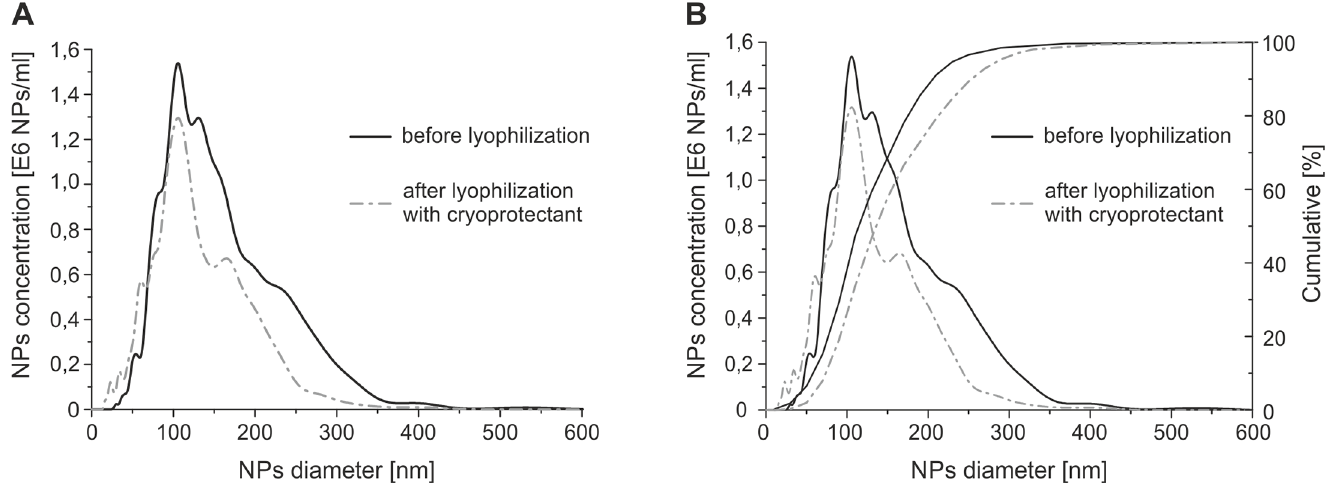
Fig 4. A) Size distribution curve and B) cumulative size distribution of Dex-NPs before and after lyophilization and rehydration. Graph represents size distribution of Dex-NPs for 55% substitution degree.